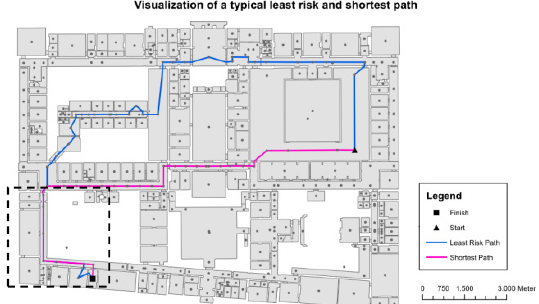
Figure 5: Comparison of a typical shortest and least risk path